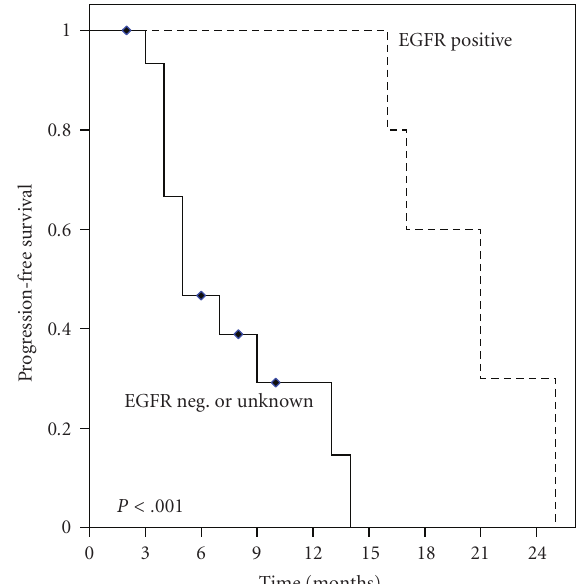
Table 1: Demographics, prognostic factors, and extent of disease.